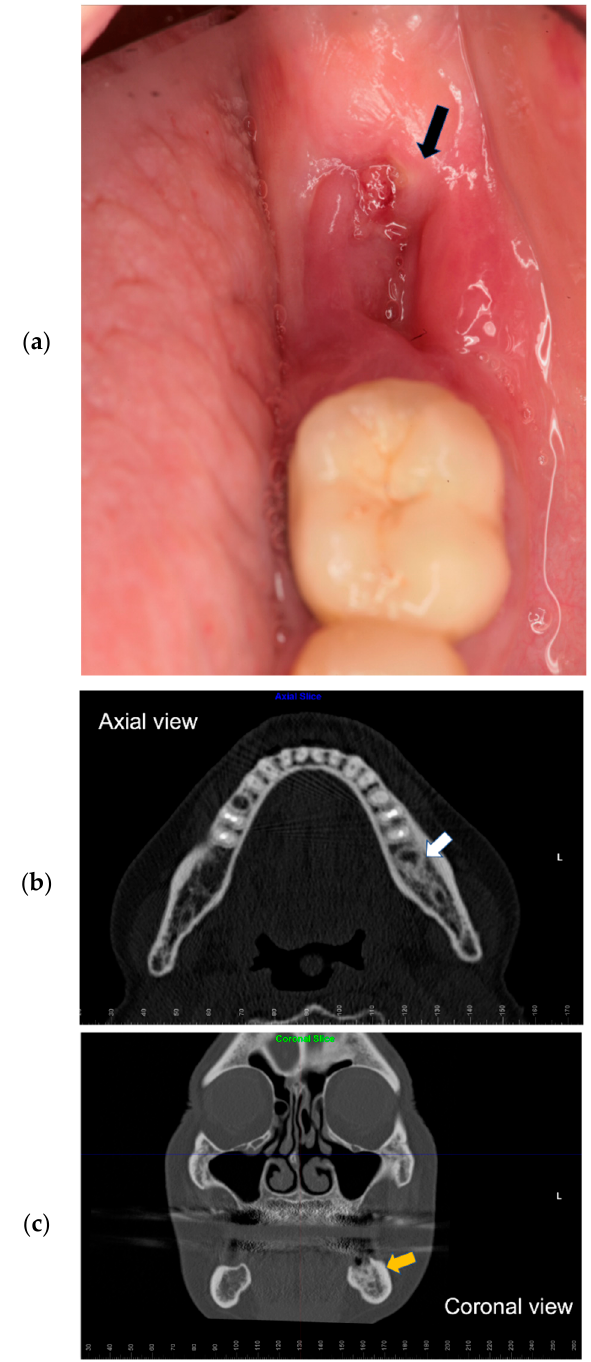
Figure 1. Stage 1 according to SICMF-SIPMO staging system: Focal MRONJ. ( a ) non-exposed MRONJ following simple tooth extraction; alveolar socket filled up with inflammatory tissue without frank bone exposure (black arrow). ( b , c ) CT scan axial view showing increased bone density (trabecular thickening and focal osteosclerosis) surrounding the post-extraction socket (white arrow); in the coronal view the increased bone density signal is limited to the alveolar bone region, above the inferior alveolar nerve canal (yellow